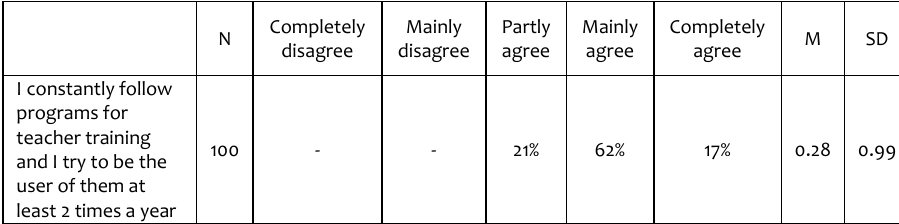
Table 7: Teachers’ readiness for